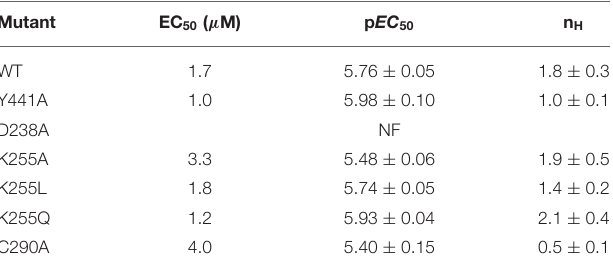
TABLE 3 | Mutant receptors in Xenopus oocytes.